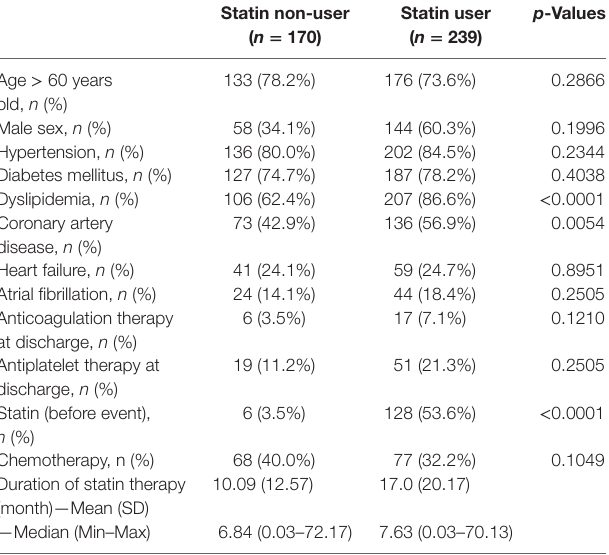
TaBle 3 | Baseline characteristics of the subjects from National Health Insurance System-National Sample Cohort data organized according to statin therapy use.